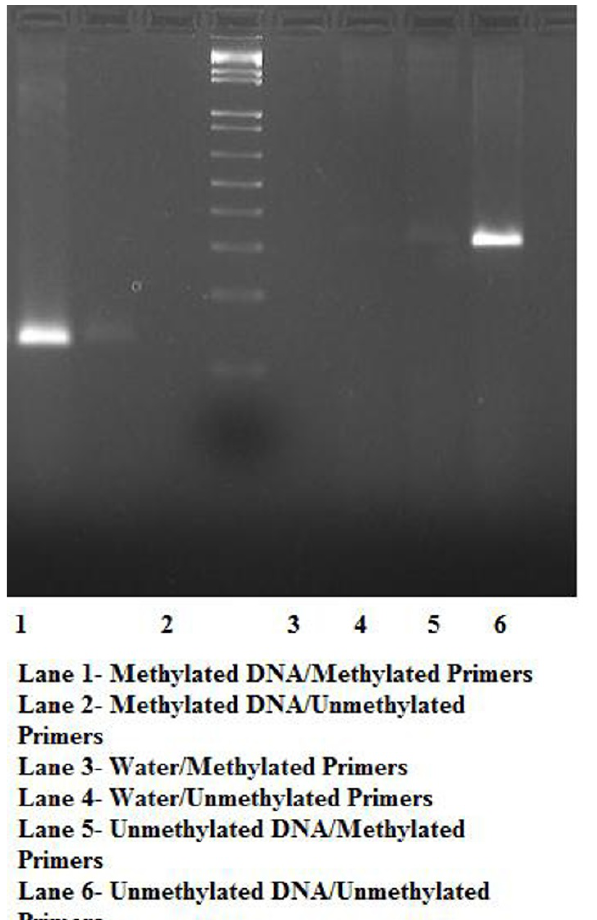
Gel electrophoresis of control and blank DNA amplicons after methylation specific PCR